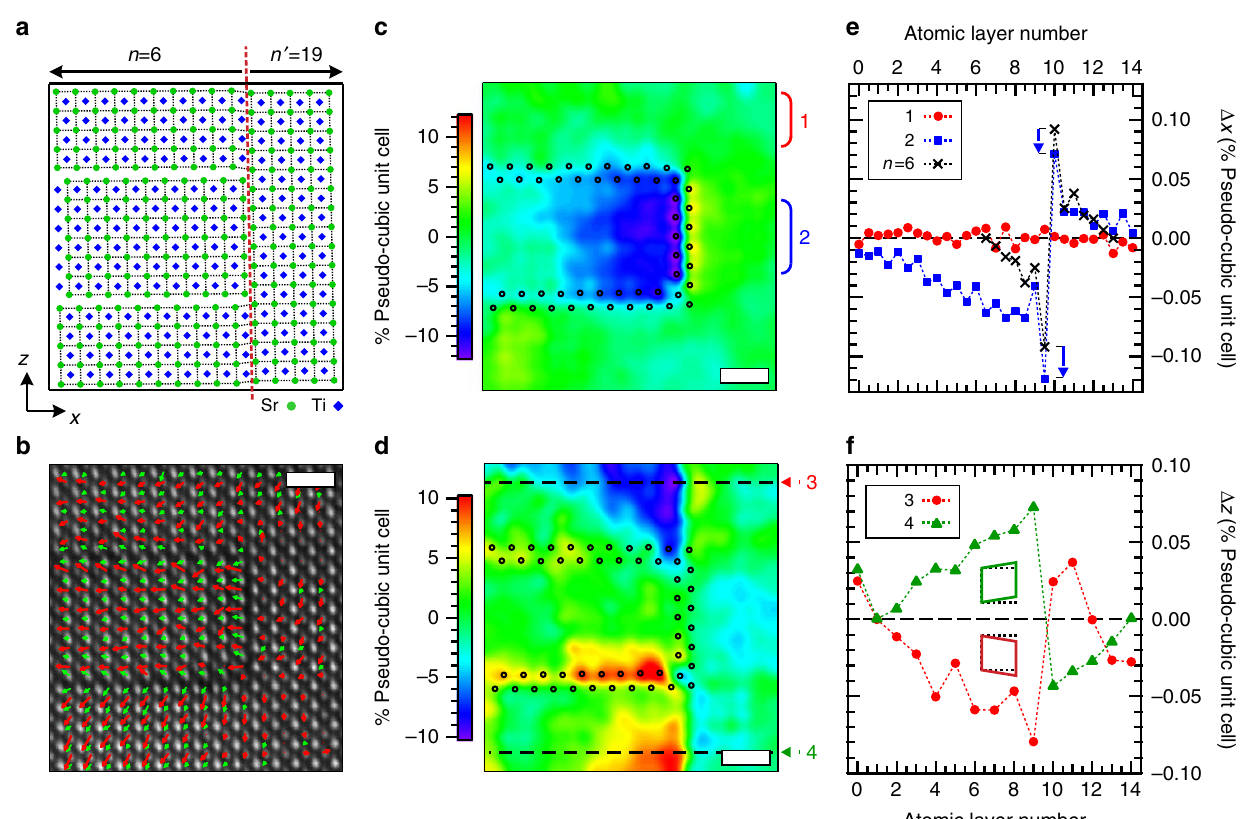
Figure 5 | Distortion of new polar phases near a (SrO) 2 stacking fault in Sr 7 Ti 6 O 19 . ( a ) Model structure of a stacking fault for the n ¼ 6 Sr n þ 1 Ti n O 3 n þ 1 RP structure. To the left of the stacking fault (red dashed line) is the n ¼ 6 structure while to the right is a perovskite slab of the n 0 ¼ 19 structure. The strontium and titanium atoms are given by green circles and blue diamonds, respectively. ( b ) Drift-corrected HAADF image of a stacking fault. Superimposed arrows qualitatively show the SrO and TiO 2 layer dipole moment near the stacking fault ( c , d ) Colour map of difference between atomic positions of the model and HAADF-STEM derived cation positions perpendicular D x (panel c ) and parallel D z (panel d ) to the stacking fault. The D x and D z maps show that the accommodation of the lattice mismatch between the n ¼ 6 and n 0 ¼ 19 structure near the stacking fault is predominantly contained within the n ¼ 6 region. The (SrO) 2 rock salt layers are indicated by the black open circles. ( e ) Line profile of D x (filled red circles) taken along the horizontal dashed line labelled (1) in panel ( c ) and its comparison to an ideal n ¼ 6 structure across the rock salt layer (open blue squares) highlight an B 10pm shift of the rock salt leading to a compressive strain in the n ¼ 6 layer. ( f ) Line profile taken along the dashed horizontal line labelled (2) in panel ( d ) from selected region #2 in ( d ) showing a monoclinic-like distortion (inset schematic) of the SrTiO 3 pseudo-cubic unit cell across the stacking fault. Scale bar,